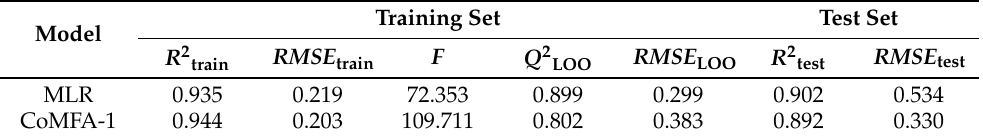
Table 4. Statistical parameters obtained using the MLR and CoMFA models.